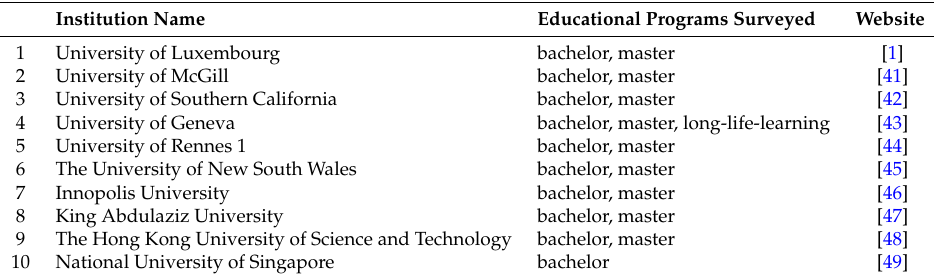
Table A2. List of the selected institutions in the educational program concept survey.